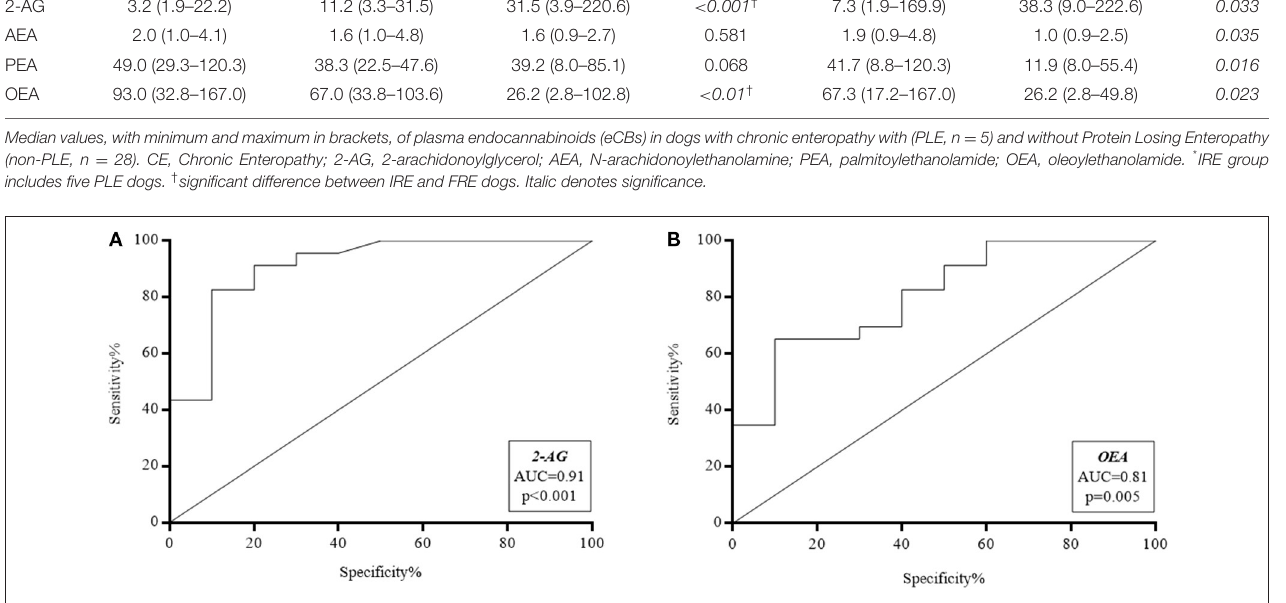
TABLE 6 | Median values, with minimum and maximum in brackets, of plasma endocannabinoids (eCBs) in dogs with Food-responsive Enteropathy (FRE, n = 10), Antibiotic-responsive Enteropathy (ARE, n = 9), and Immunosuppressive-responsive enteropathy (IRE, n = 14). eCBs